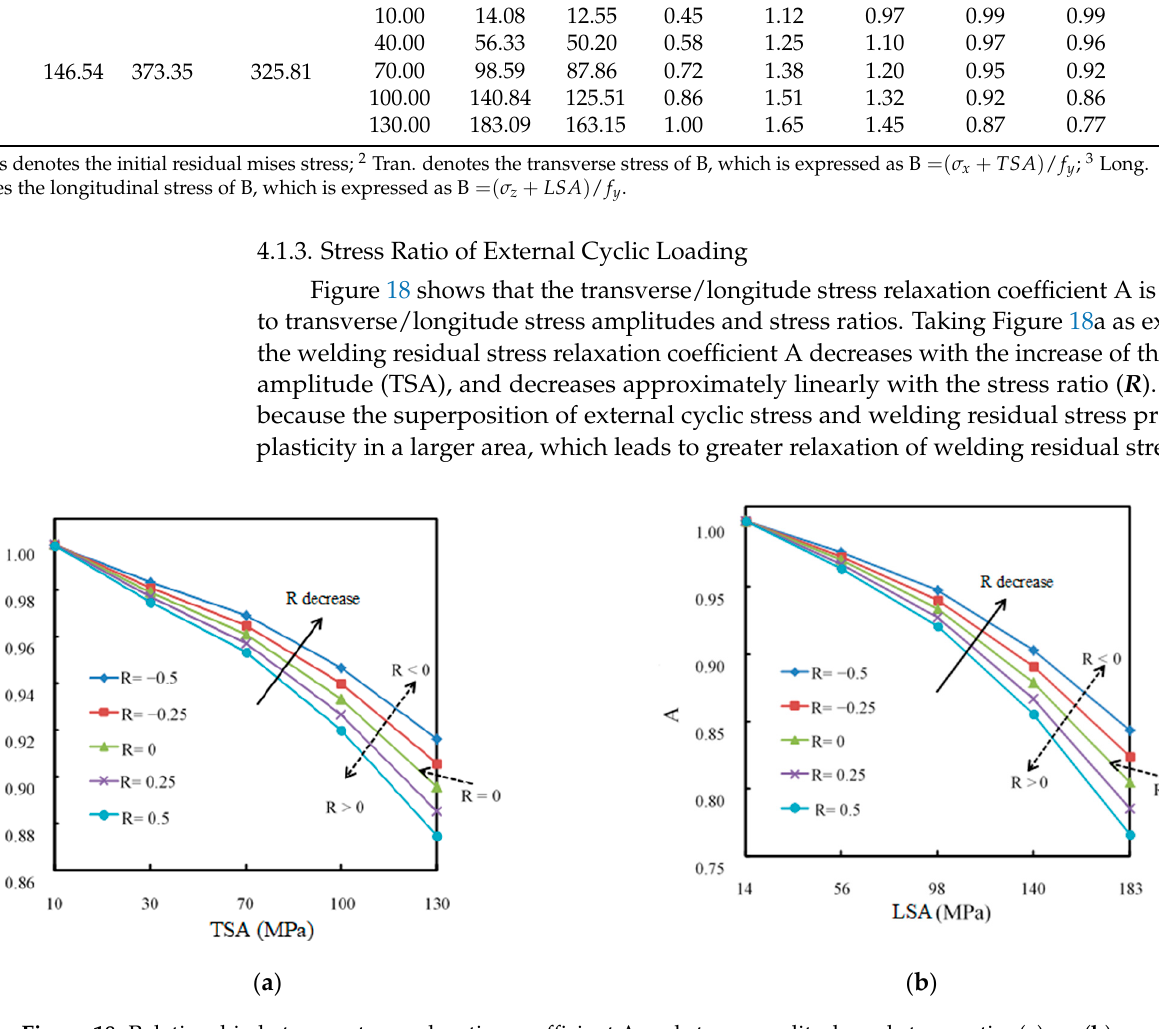
Figure 18. Relationship between stress relaxation coefficient A and stress amplitude and stress ratio: ( a ) σ x ; ( b ) σ z